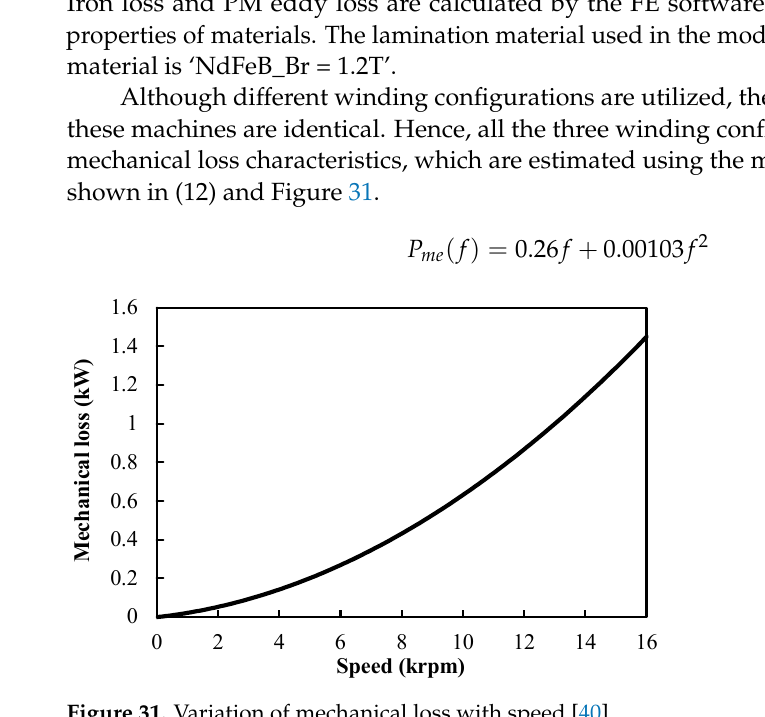
Figure 30. Amplitudes and current angles of phase currents of different winding configurations over entire speed range: ( a ) amplitudes; ( b ) current angles.